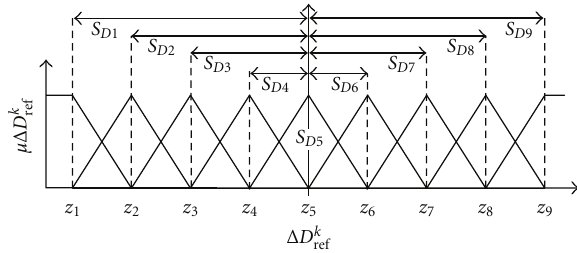
Figure 7: Membership functions coding for Δ D k